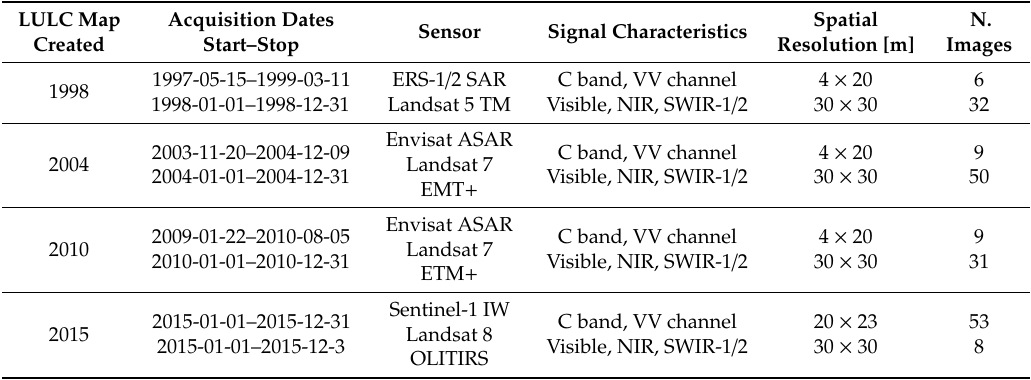
Table 1. Characteristics of the selected satellite remote sensing imagery for the resulting land use and land cover (LULC)